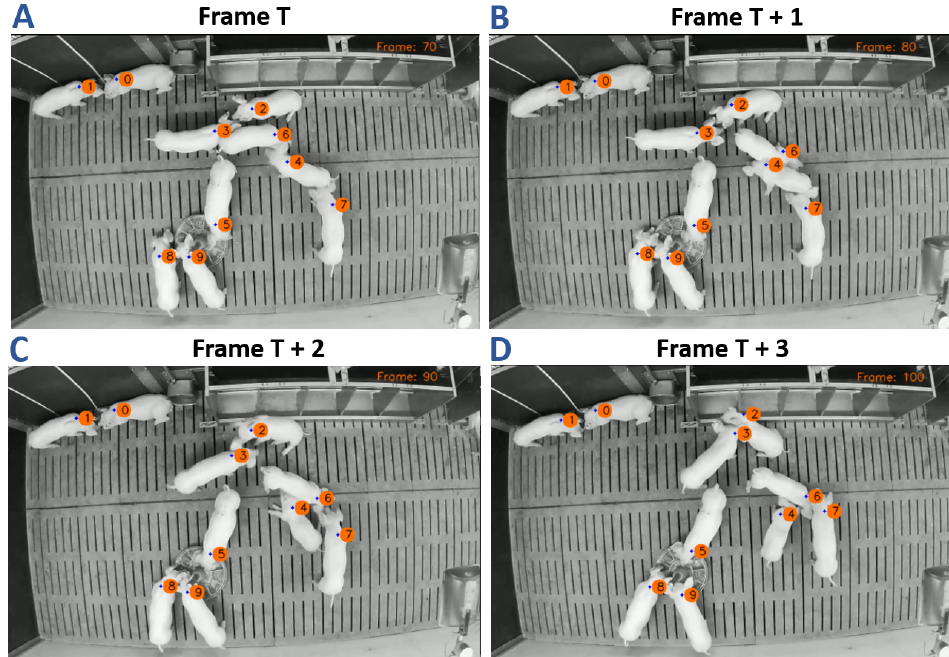
Figure 6. The multi-target pig tracking, shown for an example sequence of four frames, on a one second interval. The frame number is printed on the top, and the fps-rate was set to ten frames. The KF estimate of the shoulder point is highlighted by the blue dot, near the shoulder region of each pig. The corresponding ID is placed right of